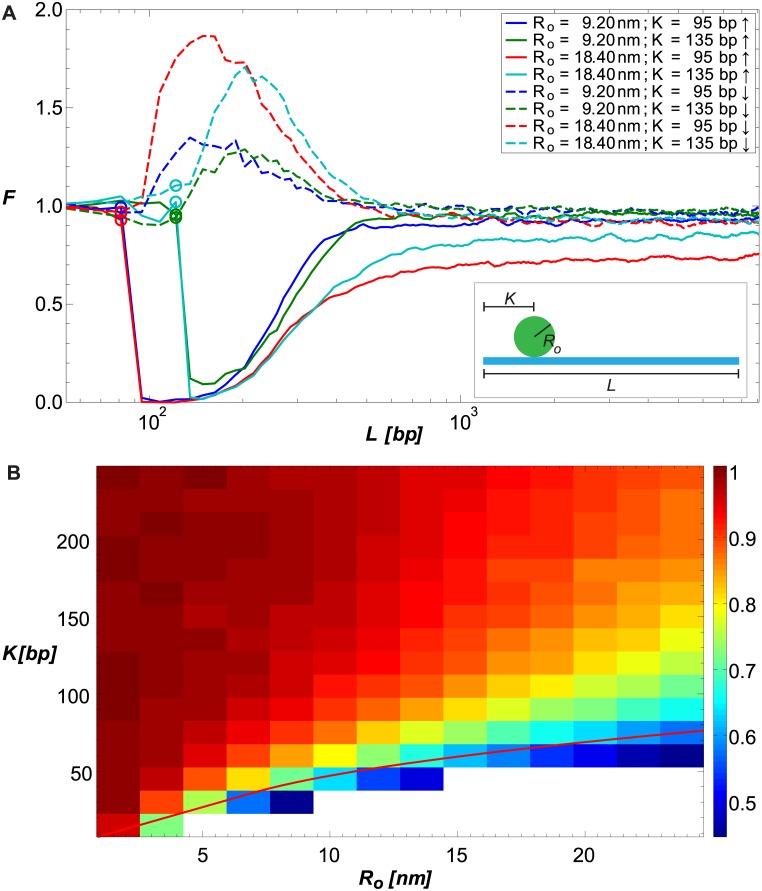
Simulating looping probability ratio F.(A) F plotted as a function of chain length L for several values of Ro and K, and γk = 0° (solid lines) or 180° (dashed lines). The locations of the protrusions are denoted by circles on the corresponding curves. (B) F∞ plotted as a function of Ro and K, for γk = 0°. F∞ is calculated numerically as the average of F(L) over the range of L values where F(L) ≈ const. The solid red curve is a visual aid: if the segment of the chain between the origin and the protrusion location was straight, points on the red curve would result in the protrusion touching the looping volume δr.